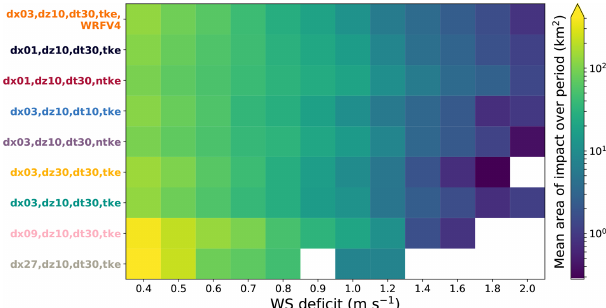
Figure 9. Average area affected by each 80m wind speed deficit (columns) over the entire simulation period for each simulation tested (rows). Yellow squares indicate larger areas of impact, with empty (white) squares indicating a lack of occurrence for that par- ticular magnitude of impact.